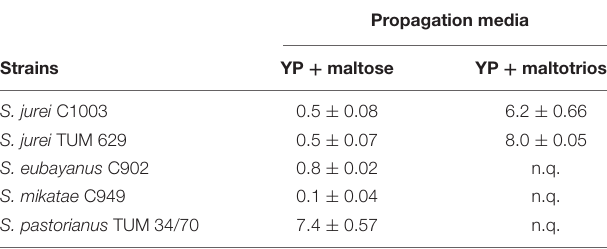
considered negligible. S. eubayanus C902 showed an activity